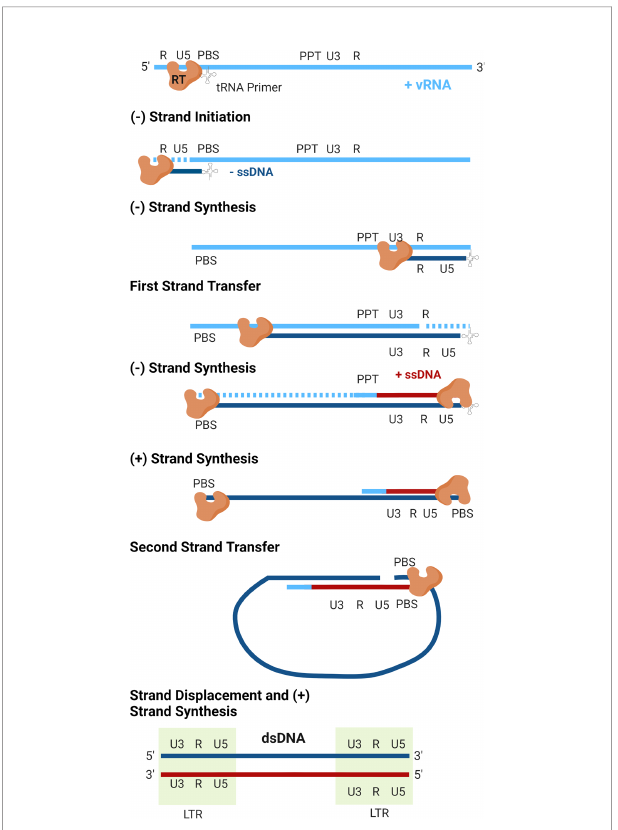
FIGURE 3 | Reverse transcription. The virally encoded reverse transcriptase (RT) converts the viral genomic RNA (vRNA) into double-stranded DNA. As replication occurs, the RNaseH activity of RT degrades the vRNA template (dashed lines). Following completion of plus-strand synthesis, the double- stranded DNA product is integrated into the host genome by integrase to form a transcriptionally active provirus (not